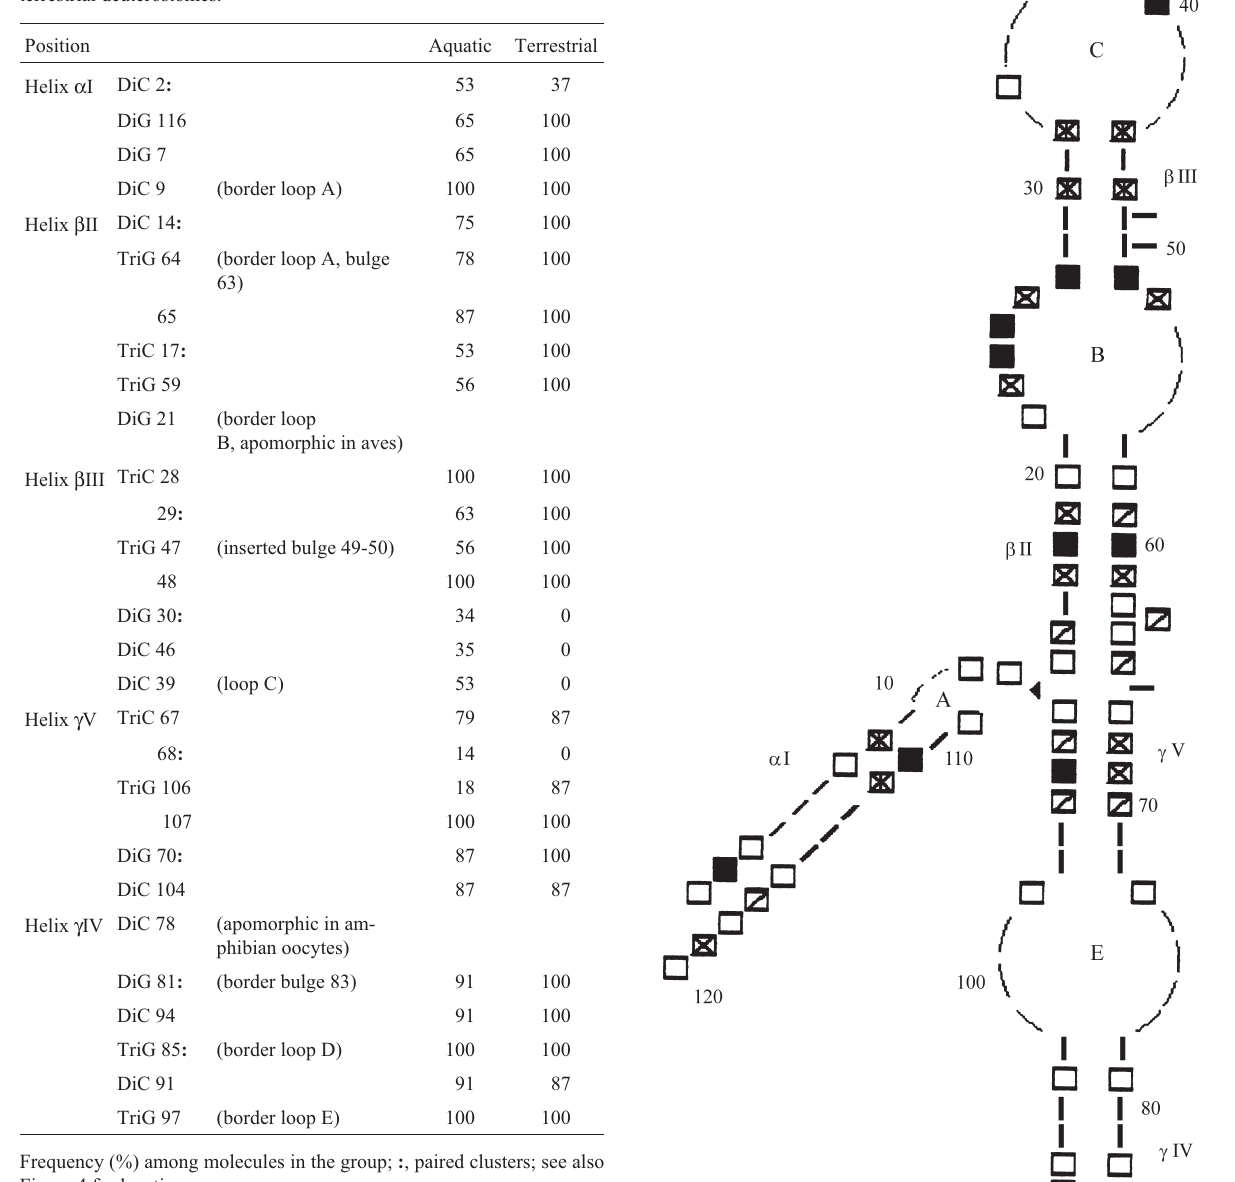
Table II - Location and frequency of G and C clusters in aquatic and terrestrial deuterostomes.